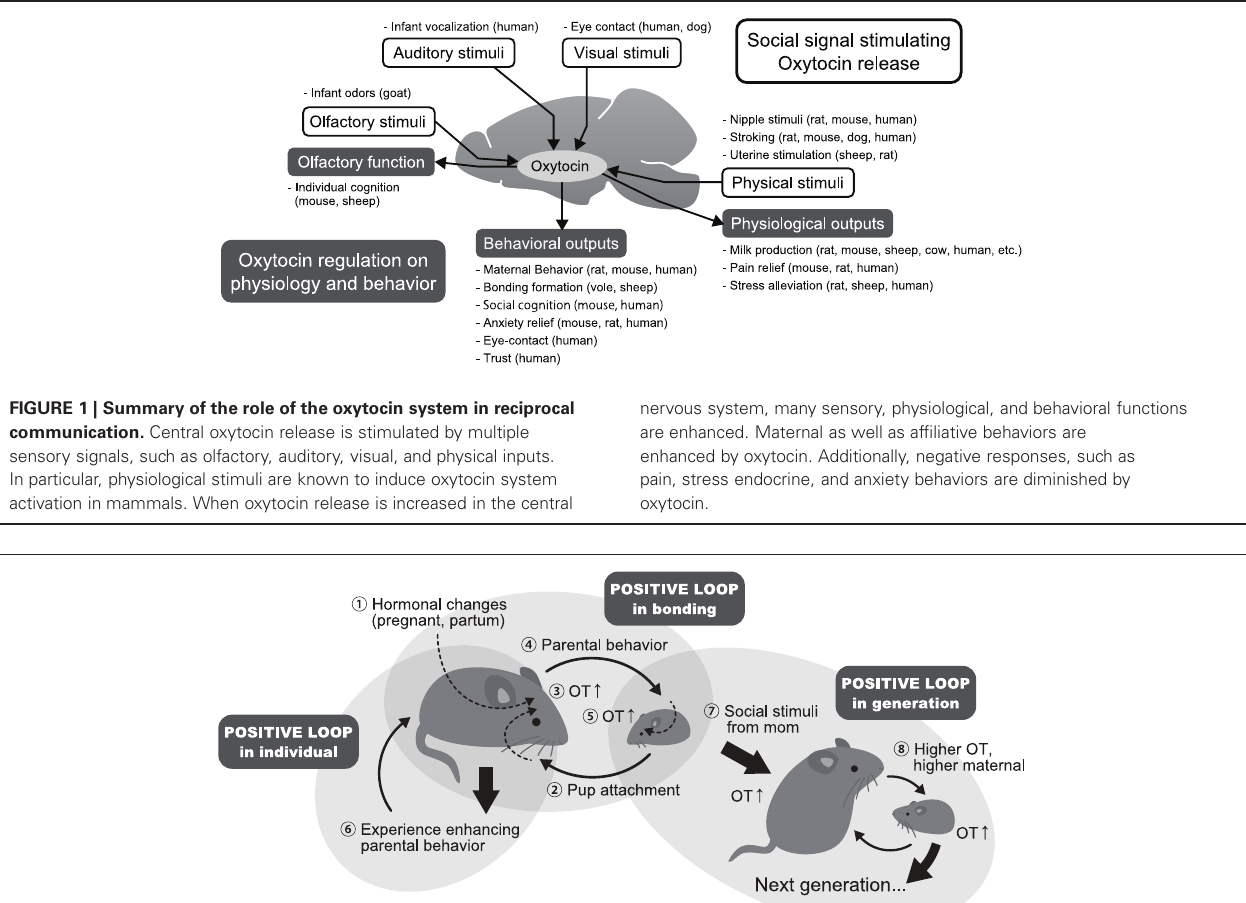
also stimulates infant OT release in the brain (5). Therefore, there is a clear positive loop of OT release in the mother-infant dyad. Once the mother experiences parenting, her maternal behavior is persistently maintained (6) positive loop in individuals. Intensive parenting care stimulates the infants’ brain development (7), which in turn brings about higher OT and parenting activities in their adulthood (8). This intensive care is also non-genetically transmitted to the next generation (positive loop in the